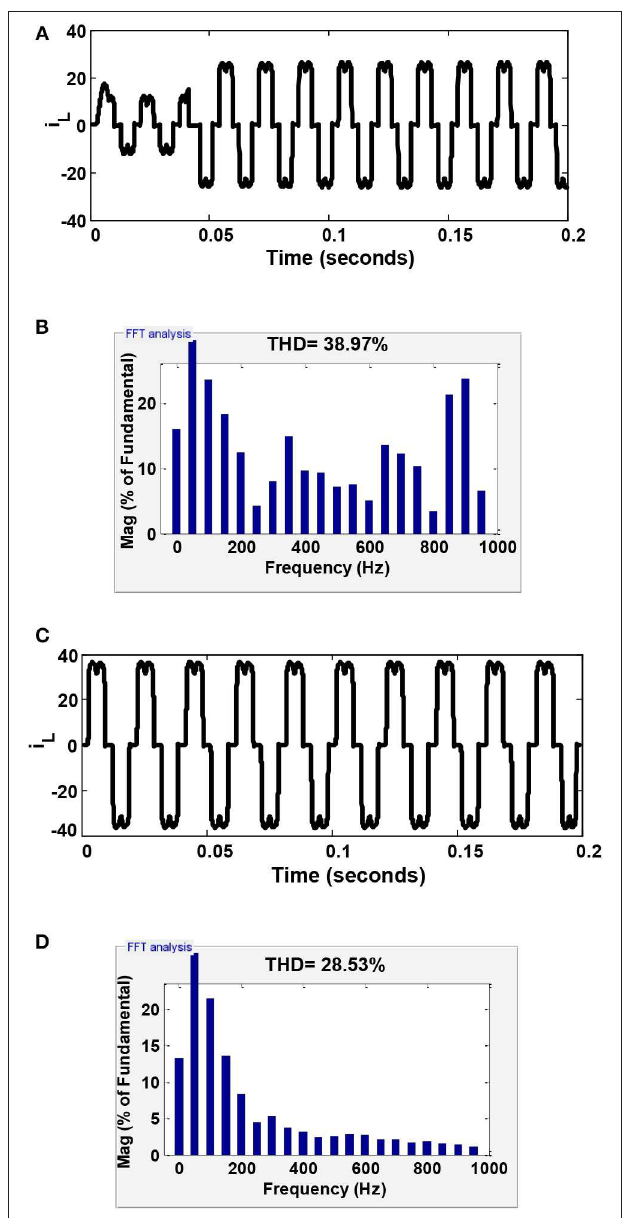
FIGURE 5 | Performance of the load current without using the MLI: (A) during an unbalance load; (B) THD value under an unbalance load; (C) during a balanced load; and (D) THD value under a balance load.